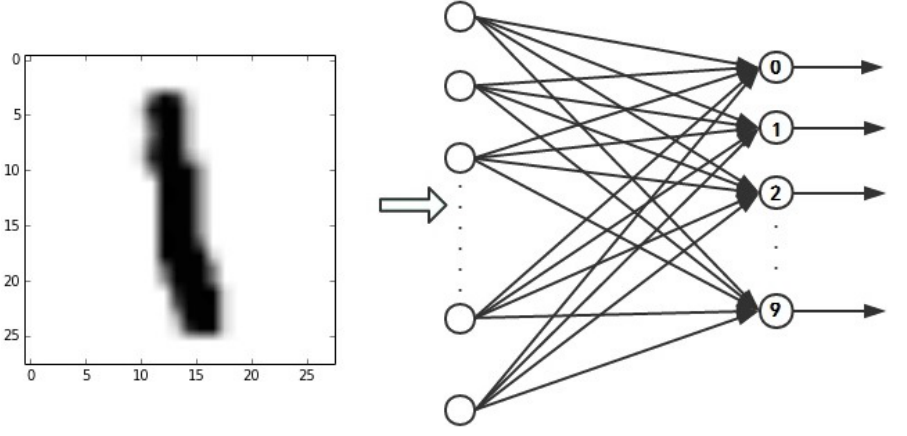
Figure 4. An example to illustrate bipolar supervised learning